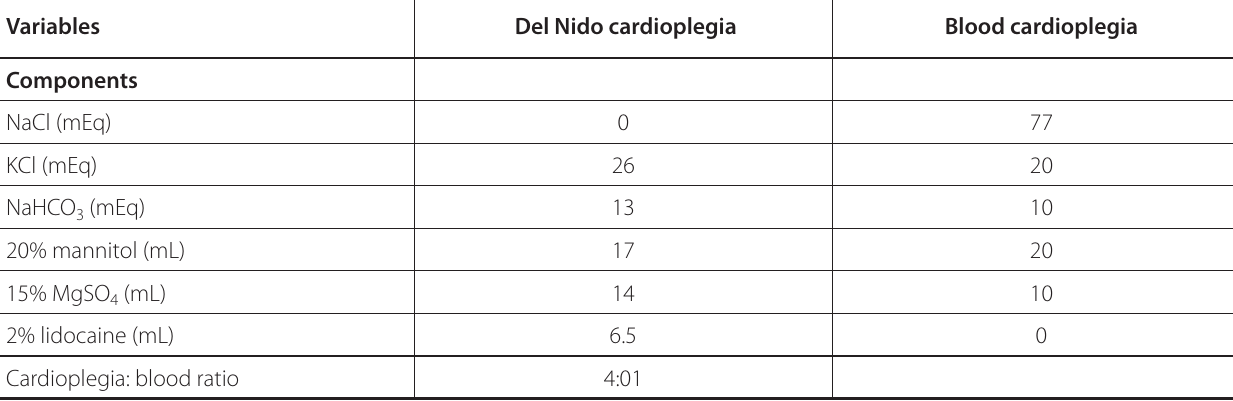
Table 1 . Components of the solution used in del Nido and blood cardioplegia.